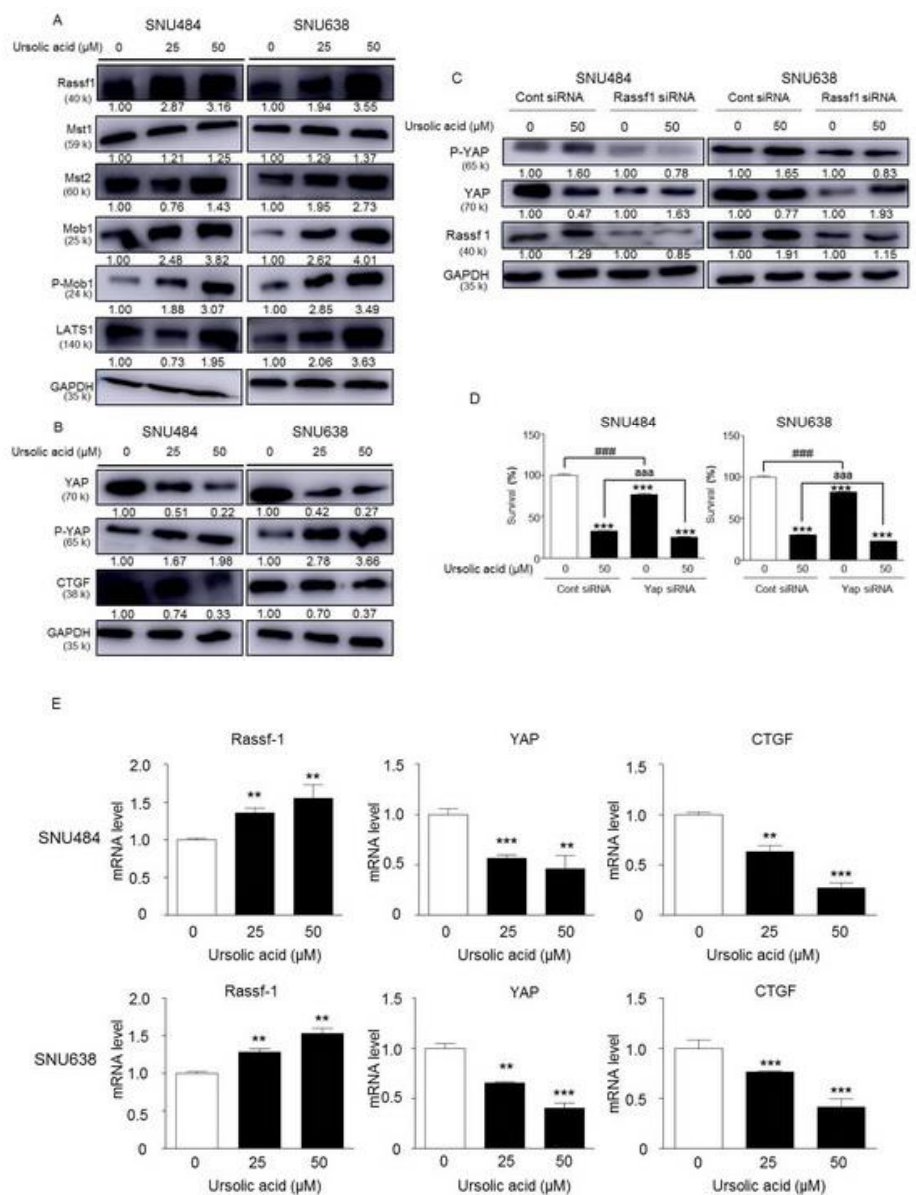
Figure 7. Effect of UA on Hippo pathway-related proteins in SNU484 and SNU638 cells. ( A ) The Hippo pathway-related proteins Rassf1, Mst1, Mst2, Mob1, p-Mob1, and LATS1 were detected after treatment with UA (0, 25, and 50 μM) using Western blot analysis. ( B ) The expressions of CTGF, YAP, and p-YAP proteins treated with UA (0, 25, and 50 μM) in SNU484 and SNU638 cell lines. GAPDH was used as the internal control. ( C ) The effects of RASSF1 inhibition after UA treatment in the Hippo pathway. SNU484 and SNU638 cells were transfected with non-target siRNA in the control group and with RASSF1 siRNA in the experimental group. After 24 h, each group was treated with UA (0 or 50 μM). The expressions of P-YAP, YAP, and RASSF1 were detected while using Western blot analysis. ( D ) The association between Hippo pathway with the cellular phenotypes after treatment of UA. The MTT assay was performed to determine the cell survival after UA treatment in YAP siRNA-transfected SNU484 and SNU638 cells. UA suppressed the cell survivals reduce by Yap silencing in SNU484 and NSU638 cells. *** p < 0.001 when compared to the control. ### p < 0.001 when it compared between control siRNA and Yap siRNA treatment. aaa p < 0.001 when it compared between control siRNA and Yap siRNA with UA treatment. ( E ) The mRNA levels of Rassf1, YAP, and CTGF were measured through real-time PCR. Data are expressed as mean ± SE. Values were normalized to GAPDH.